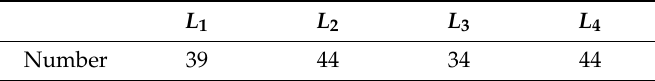
Table 7. The numbers of convergence measurement points for each